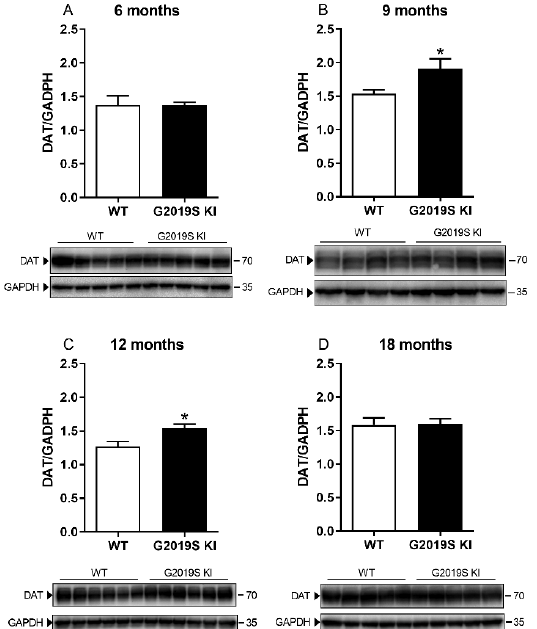
Figure 1. DAT levels are transiently elevated in G2019S KI mice. Western blot analysis of DAT levels KI mice and age-matched WT controls. Data are expressed as mean ± SEM of n = 6 mice per group. Statistical analysis was performed using the Student t -test, two-tailed for unpaired data. * p < 0.05, different from